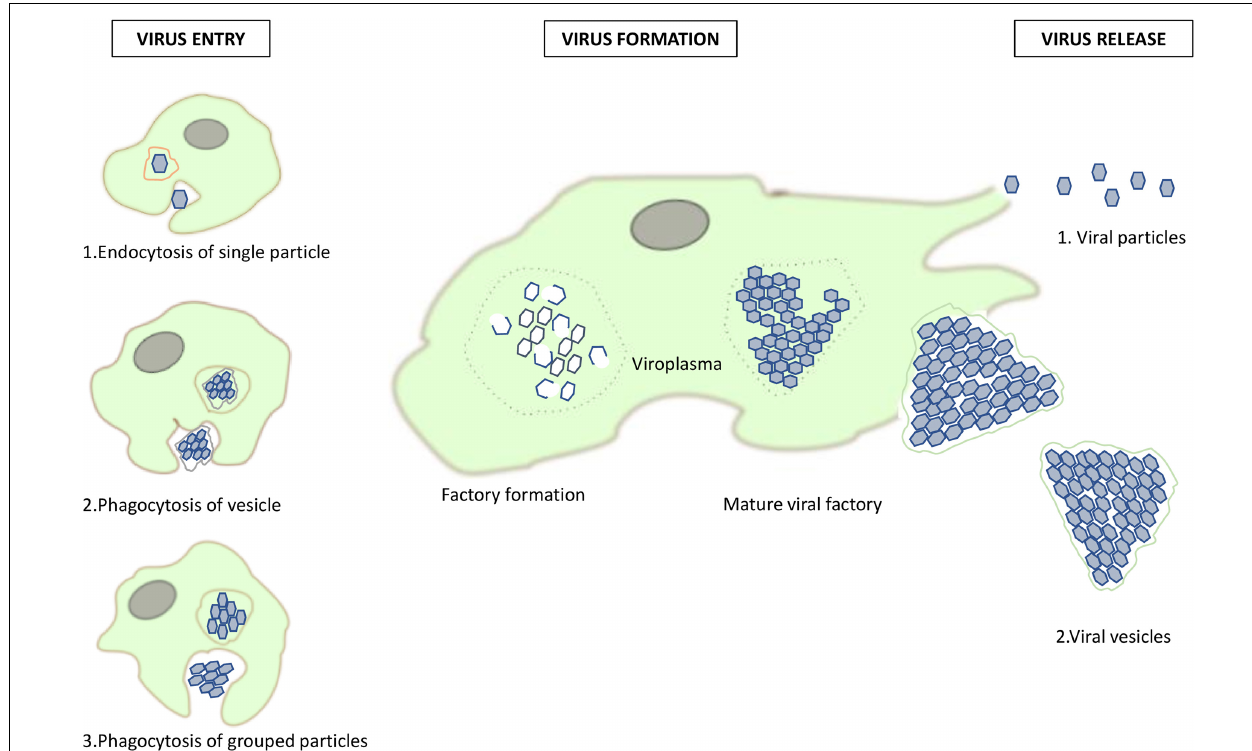
FIGURE 3 | Replication cycle of marseilleviruses. A summary of the different pathways of marseillevirus entry and new virion assembly in amoeba, and their release